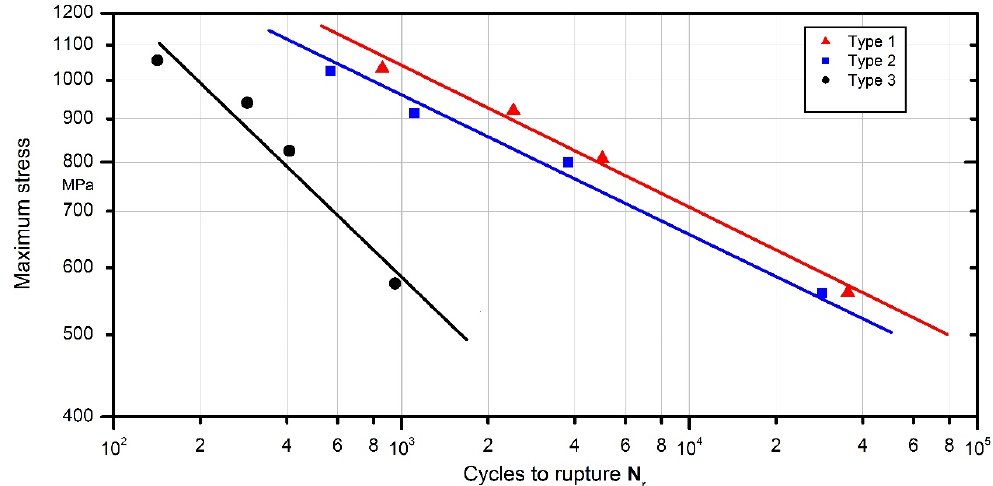
Figure 5. Wöhler lines of load controlled fatigue tests of Type 1–3 samples. Figure 5. The course of maximum total strain during the fatigue load process of Type 2 samples.